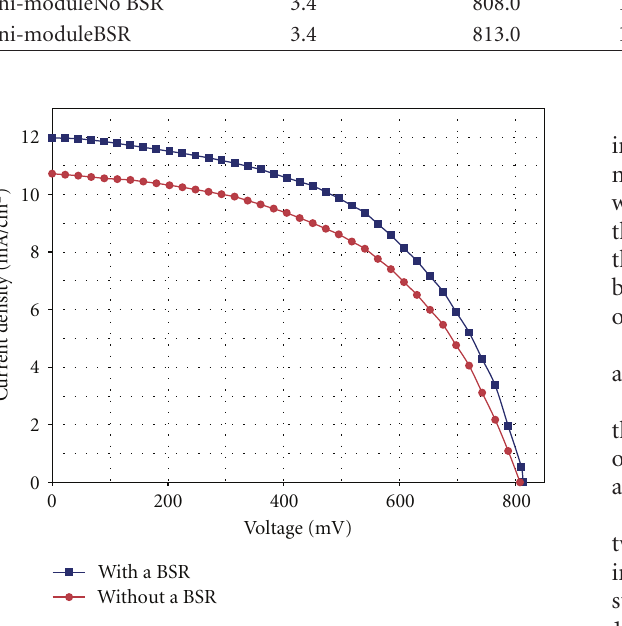
Figure 7: One sun J-V curves from the 2-cell minimodule before (blue) and after (black) the white paint BSR was